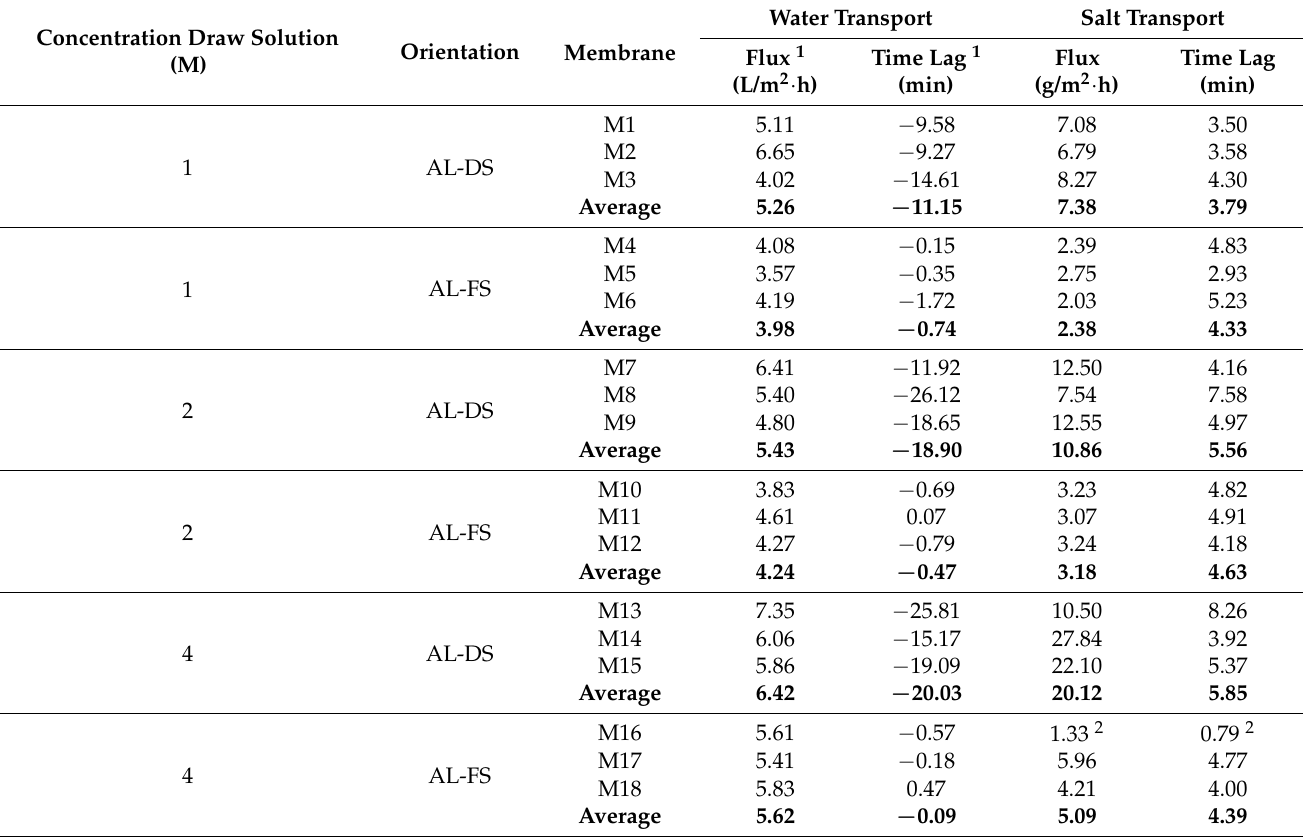
Table 2. Summary of dynamic experiments with Toray low-pressure membrane at 25 ± 0.3 ◦ C. The effect of the draw solution concentration in AL-DS and AL-FS membrane